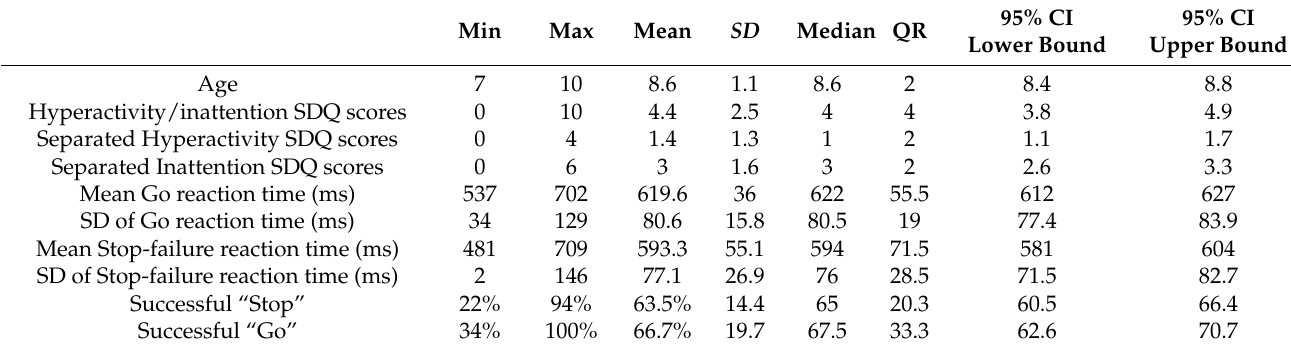
Table 1. Psychometric and behavioral data.